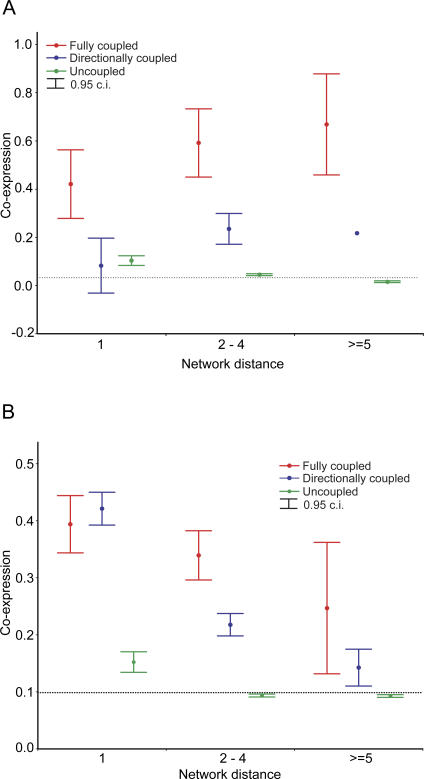
The Effect of Flux Coupling and Network Distance on Co-Expression for E. coli (A) and S. cerevisiae (B)(A) The dashed baseline indicates the degree of co-expression between random gene pairs. The confidence interval of directionally coupled pairs at d ≥ 5 is absent, as it contains too few data points (n = 2) for reliable calculation.(B) Relative variance components (i.e., the fraction of total variance in co-expression explained by coupling and distance) were estimated by a general linear model where both flux coupling and distance were treated as random effects in an unbalanced factorial ANOVA design. Expected means squares were used for the estimation (Statistica 6.0, Statsoft). Flux coupling and network distance explain 16.8% and 7.3% of the variance in co-expression, respectively (interaction between the two factors explains 3.7%). A maximum likelihood estimation of variance components gave very similar results (coupling: 14%, distance: 7.1%, and interaction: 3.8%, Statistica 6.0, Statsoft). Note that the average network distance is ∼4.5.